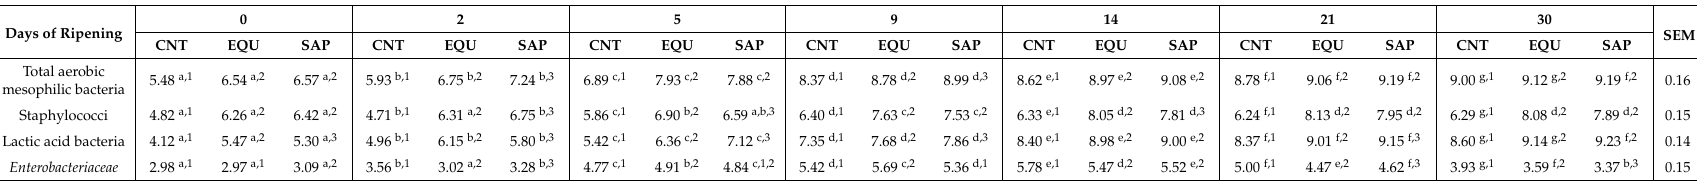
Table 3. Evolution of the plate counts (log CFU / g) of total aerobic mesophilic bacteria (SPCA), staphylococci (MSA), lactic acid bacteria (MRS) and Enterobacteriaceae (VRBGA) along the manufacturing process of Galician chorizo made without and with starter cultures (means of three replicates in each sausage group). 0 DaysofRipening